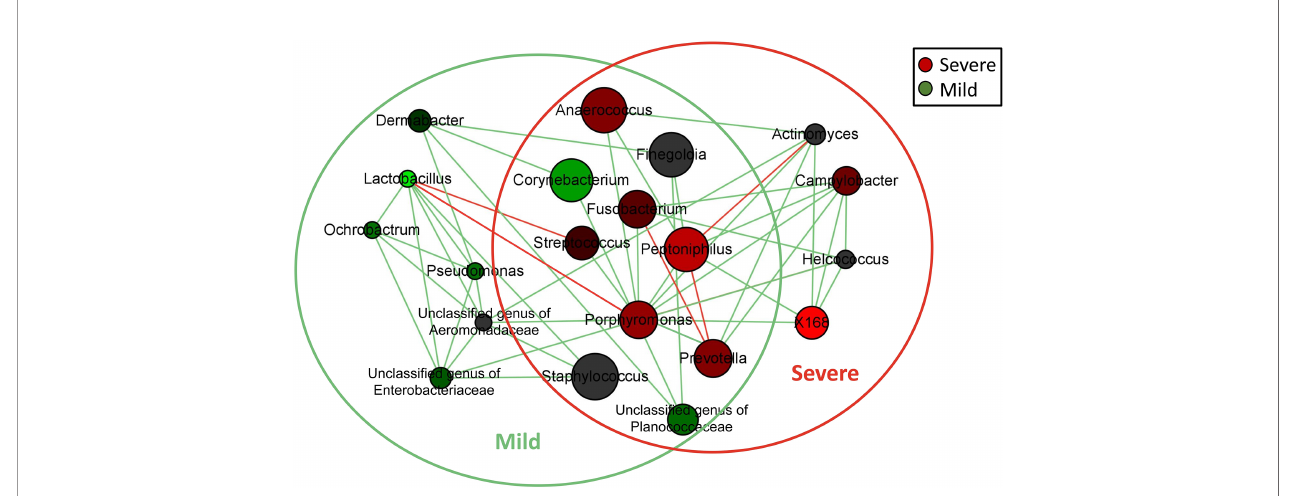
FIGURE 4 | Network analysis of microbiome in patients with dermis paronychia. Co-occurrence relationship of the key dermic microorganisms in patients with different disease severities are shown at the genus level. Genus is presented as nodes, genus abundance is presented as node size, and edges are represented based on their